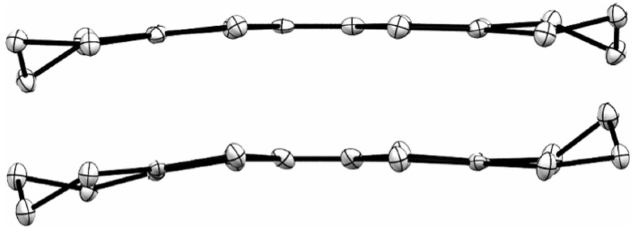
Figure 3 Side view of the BEDT-TTF molecules (top: in the dimer; bottom: the other molecule). Displacement ellipsoids are drawn at the 50% probability